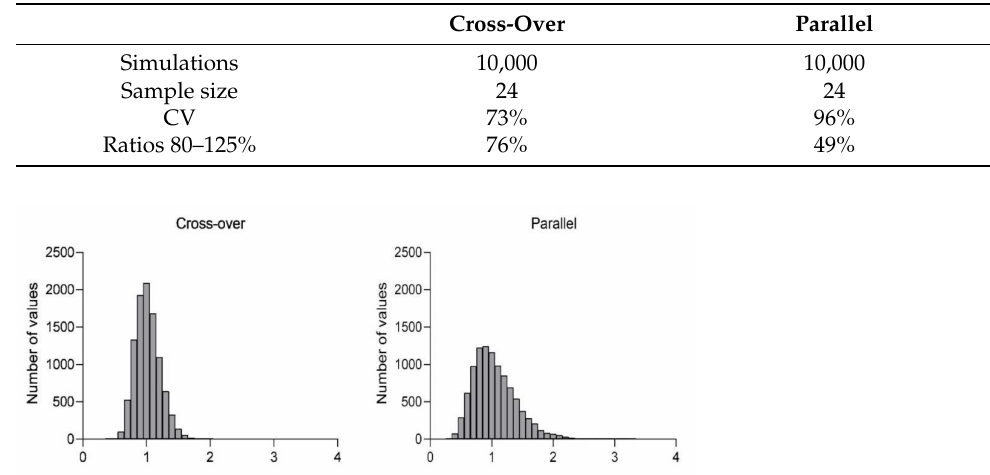
Figure 3. Histograms showing distribution of the resulting ratios in cross-over and parallel